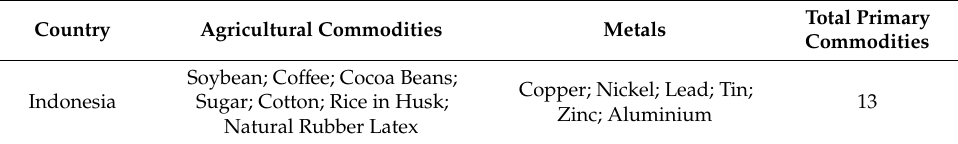
Table 3. List of Primary Imported Commodities Selected for Simulation.